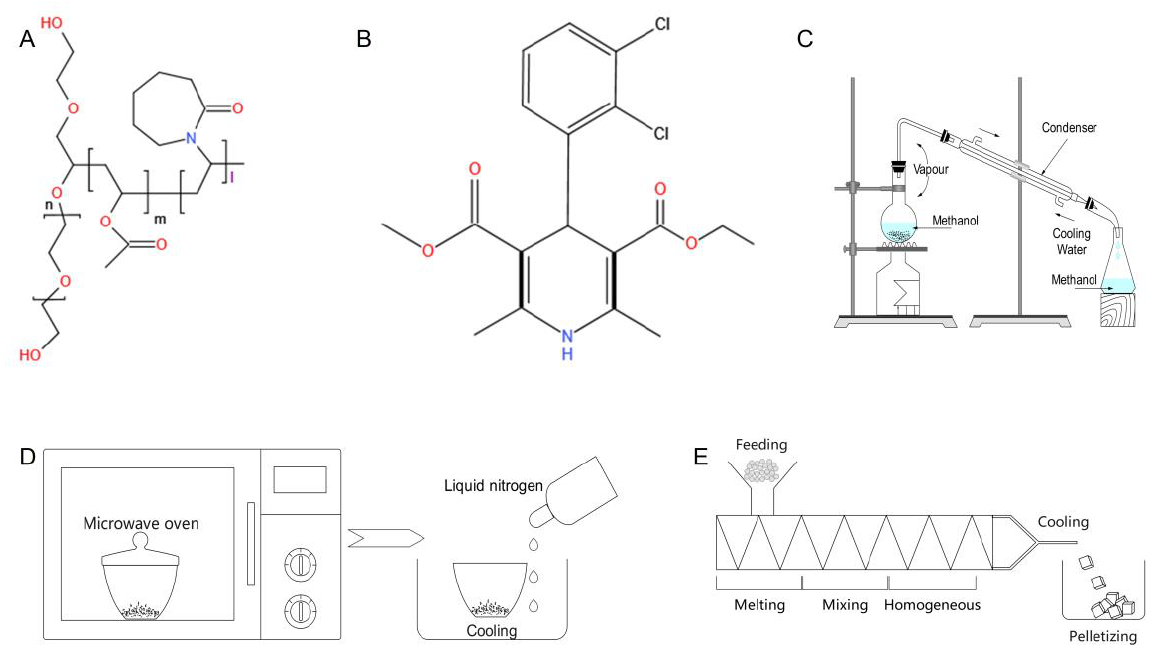
Figure 1. ( A , B ) Chemical structure of self-micellizing polymer Soluplus ® ( A ) and hypotensive BCS II drug FEL ( B ). ( C – E ) Fabrication techniques including discontinuous thermodynamic disordering approaches (solvent evaporation ( C ) and microwave irradiation-quench cooling ( D )) and continuous thermodynamic disordering approach (( E ), hot-melt extrusion).